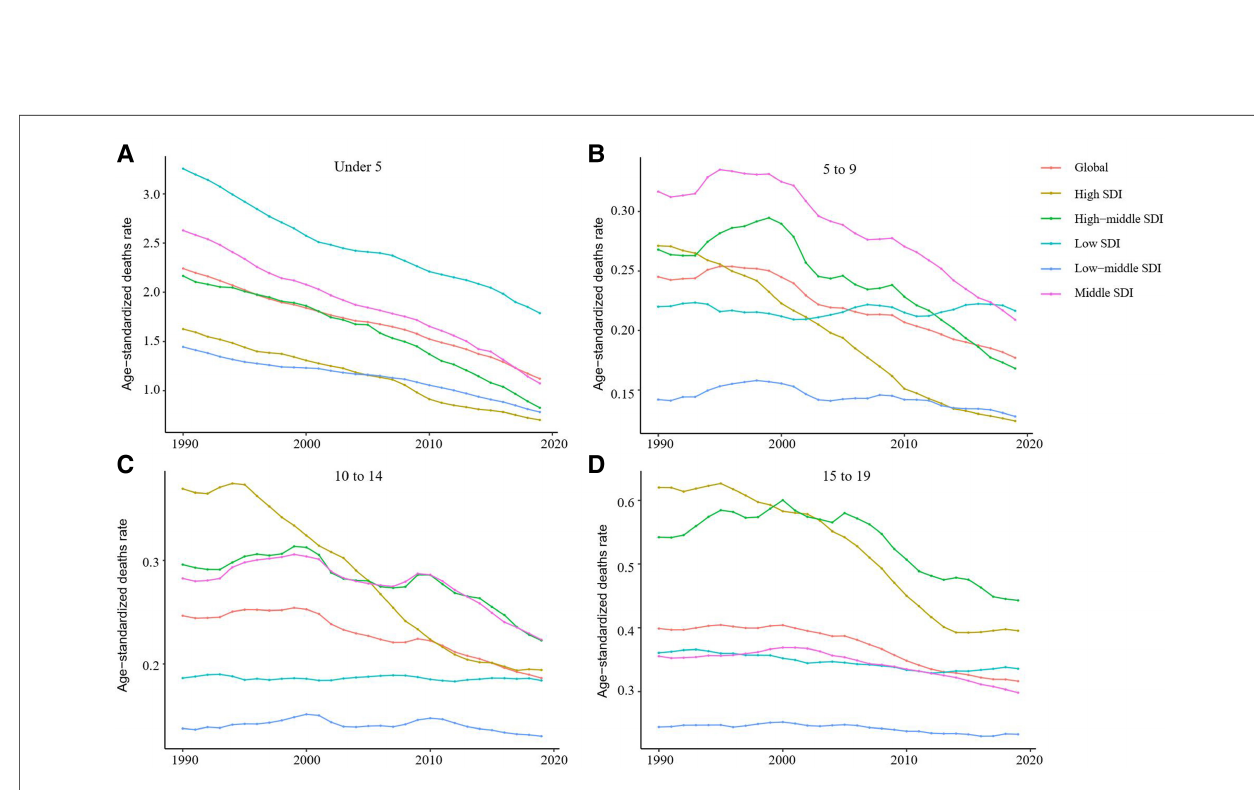
FIGURE 11 Change in trends of age-standardized death rate due to childhood myocarditis and cardiomyopathy by age group and SDI from 1990 to 2019. ( A ) Age- standardized death rates for myocarditis and cardiomyopathy in children under 5 years of age declined signi fi cantly from 1990 to 2019 in all regions with different SDI levels. ( B ) Change in trend of age-standardized death rate for 5 – 9-year-olds. ( C ) Change in trend of age-standardized death rate for 10 – 14- year-olds. ( D ) Change in trend of age-standardized death rate for 15 –